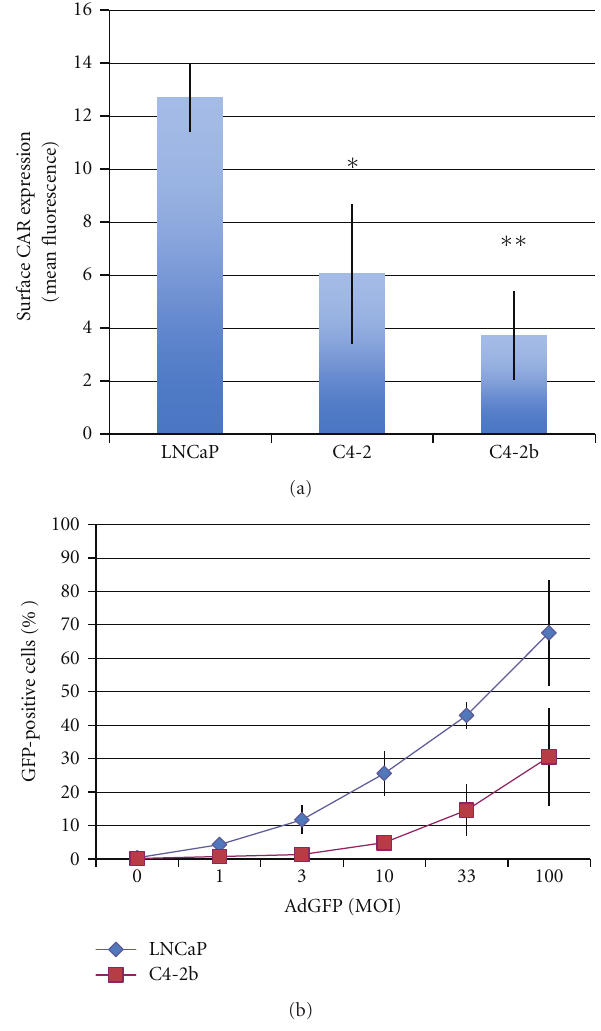
Figure 2: CAR expression and adenoviral infectivity. (a) Surface CAR expression was determined by flow cytometry. Mean fluores- cence of cells stained with CAR antibody minus mean fluorescence of cells stained with the isotype control was determined. The average ± SD was calculated, and significance was determined using the student t -test. ∗ P < 0 . 05, ∗∗ P < 0 . 0005. (b) Adenoviral infectivity was determined by the expression of GFP 48 hours after transduction. All data shown are the mean ± SD from 3 independently performed